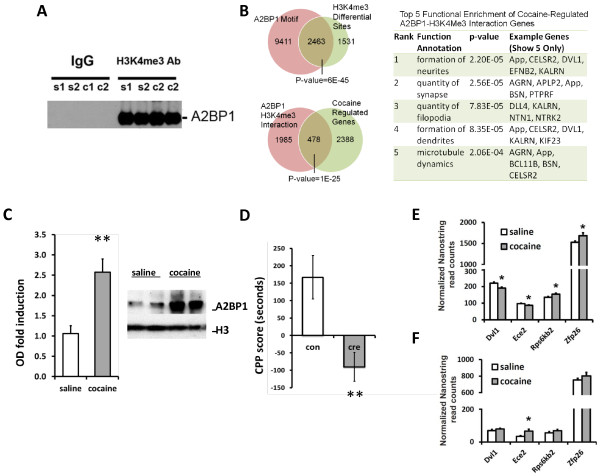
Role of A2BP1 in cocaine responses. (A) Co-immunoprecipitation shows A2BP1 western blotting of H3K4me3 or IgG pulldown of whole NAc lysate. Two repeated cocaine-treated samples and two saline control samples are shown. (B) The two Venn diagrams show overlap between: A2BP1-motif containing genes versus H3K4me3 differential site-containing genes (upper); A2BP1 motif- and H3K4me3 differential site-containing genes versus cocaine-regulated differential and spliced genes (lower). The table shows the top five enriched functional terms of the 478 overlapped genes from the lower Venn diagram. (C) Western blot analysis of A2BP1 in nuclear lysates of NAc after repeated cocaine. Error bars are mean ± standard error of the mean (SEM) derived from eight cocaine treated and eight saline treated control mice, respectively. (D) Conditioned place preference (CPP) scores of AAV-Cre-GFP-injected A2bp1loxP/loxP mice (cre) with AAV-GFP-injected A2bp1loxP/loxP mice as control (con). Error bars are mean ± SEM derived from seven cre and eight control samples. (E) Four predicted A2BP1 target candidate genes were chosen for Nanostring validation. All show the same direction of transcription change after chronic cocaine treatment as observed in RNA-seq. Error bars are mean ± SEM derived from 14 cocaine and 14 saline treated samples. (F) Cocaine-induced transcription change as observed in (E) are lost (Rps6kb2, Zfp26, Dvl1) or in one case reversed (Ece2) when A2bp1 was conditionally knocked down by using AAV-Cre viral injection in NAc. Error bars are mean ± SEM derived from five cocaine and six saline treated samples. *P < 0.05, **P < 0.01.